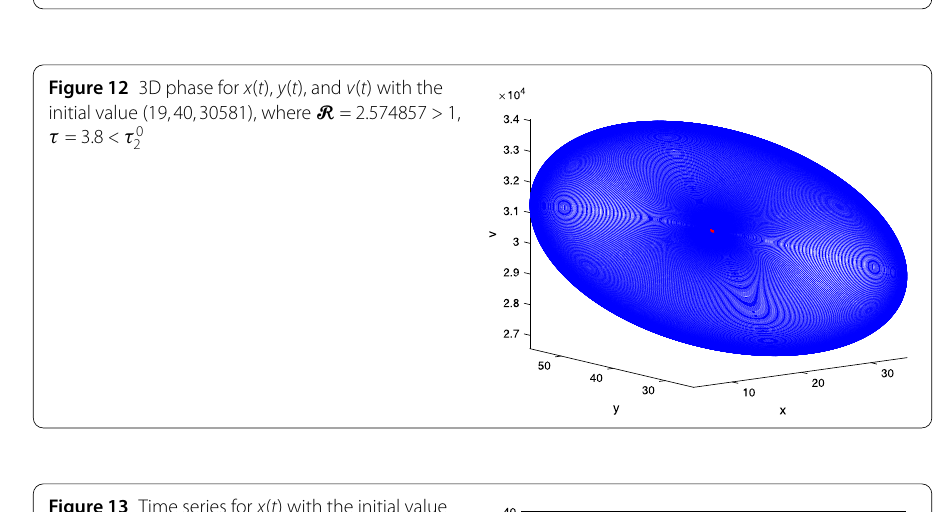
Figure 13 Time series for x ( t ) with the initial value (30,75,29000), where R = 2.574857 > 1, τ